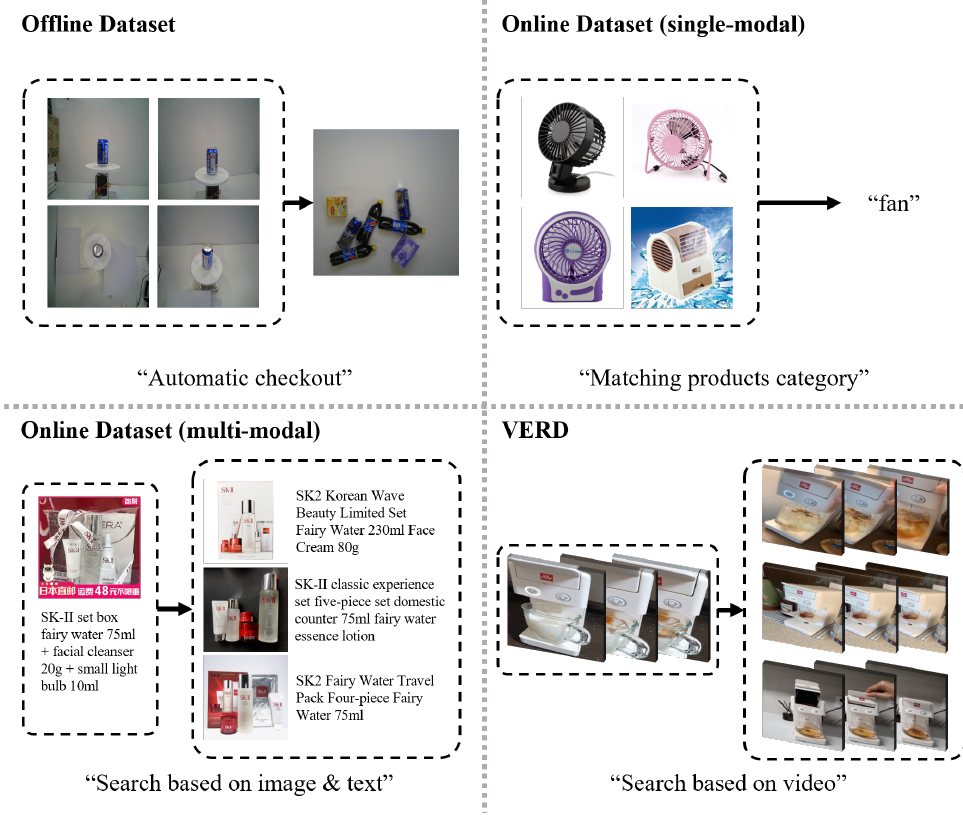
Figure 1. Comparison of datasets related to object-centric